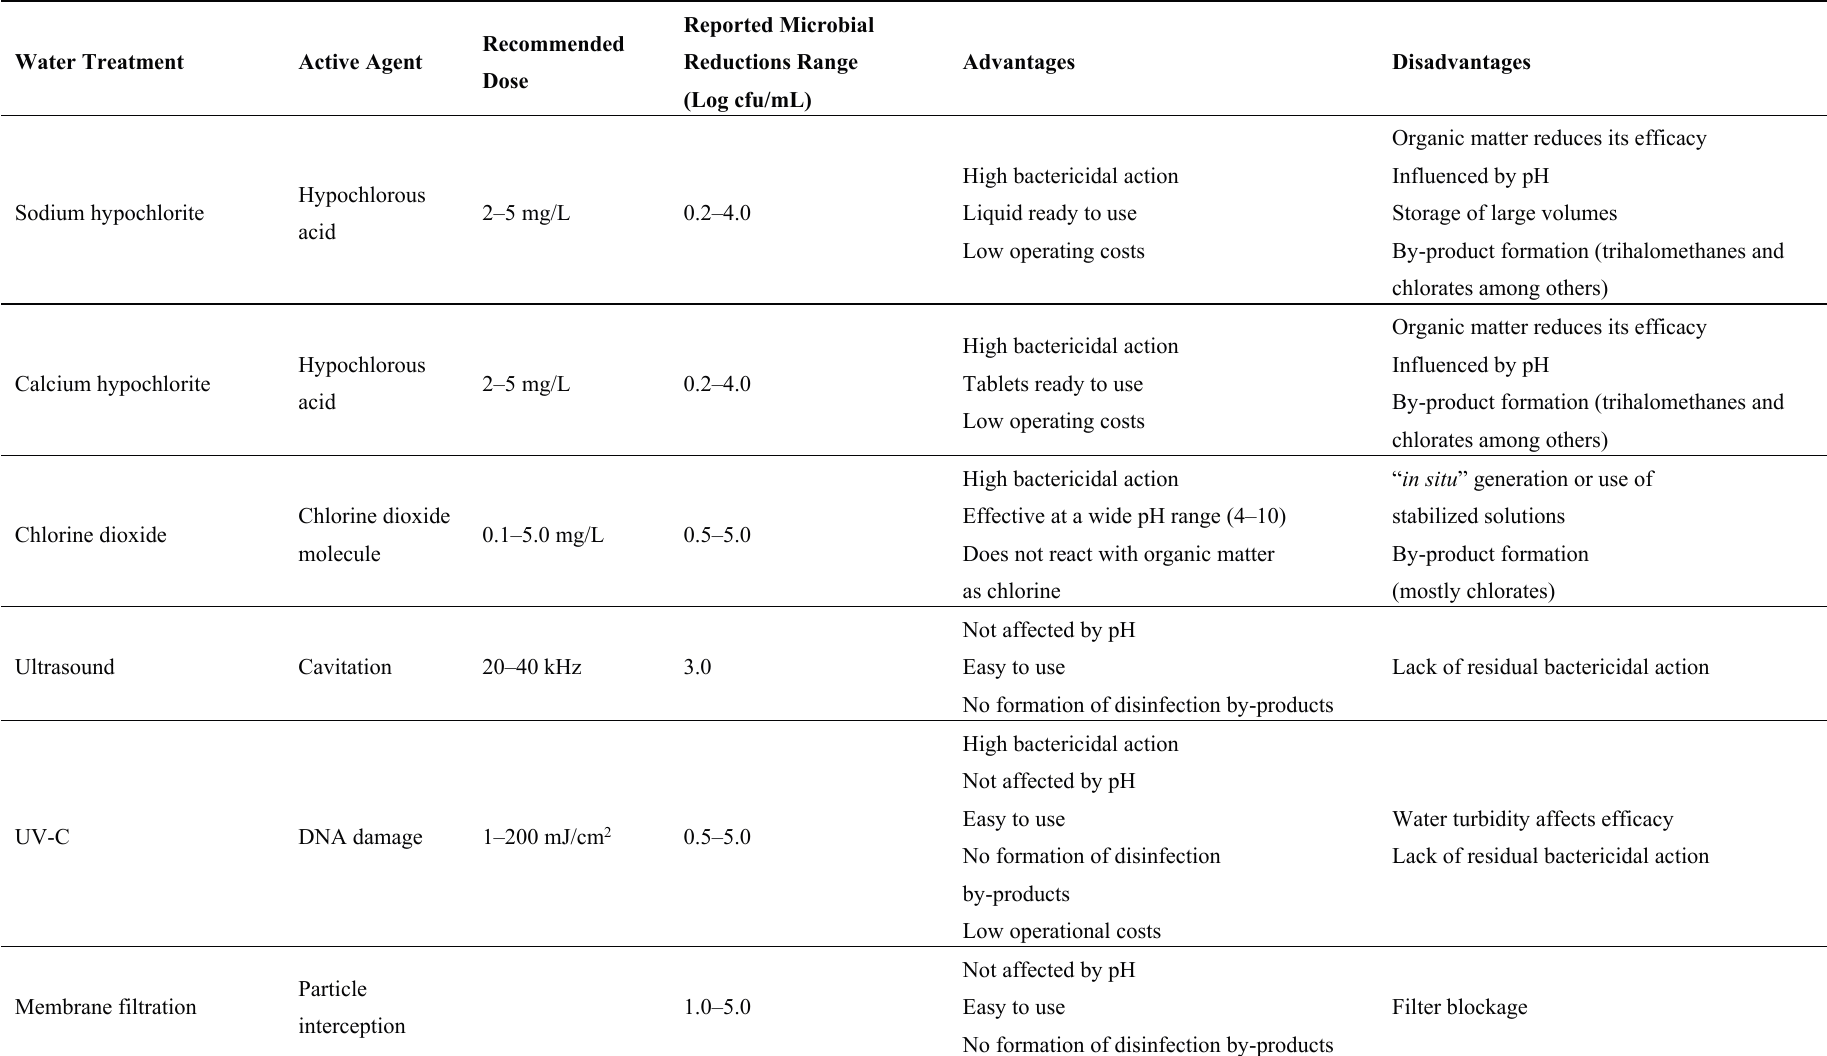
Table 2. Characteristics, advantages and disadvantages of water treatment technologies for irrigation